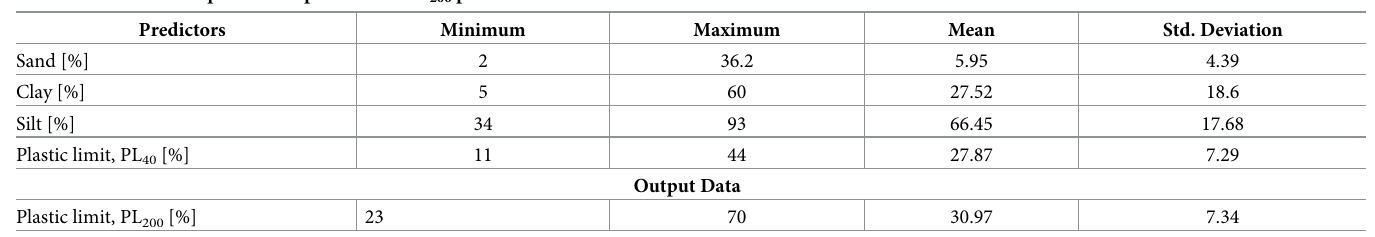
Table 1. Statistics of input and output data for PL 200 prediction